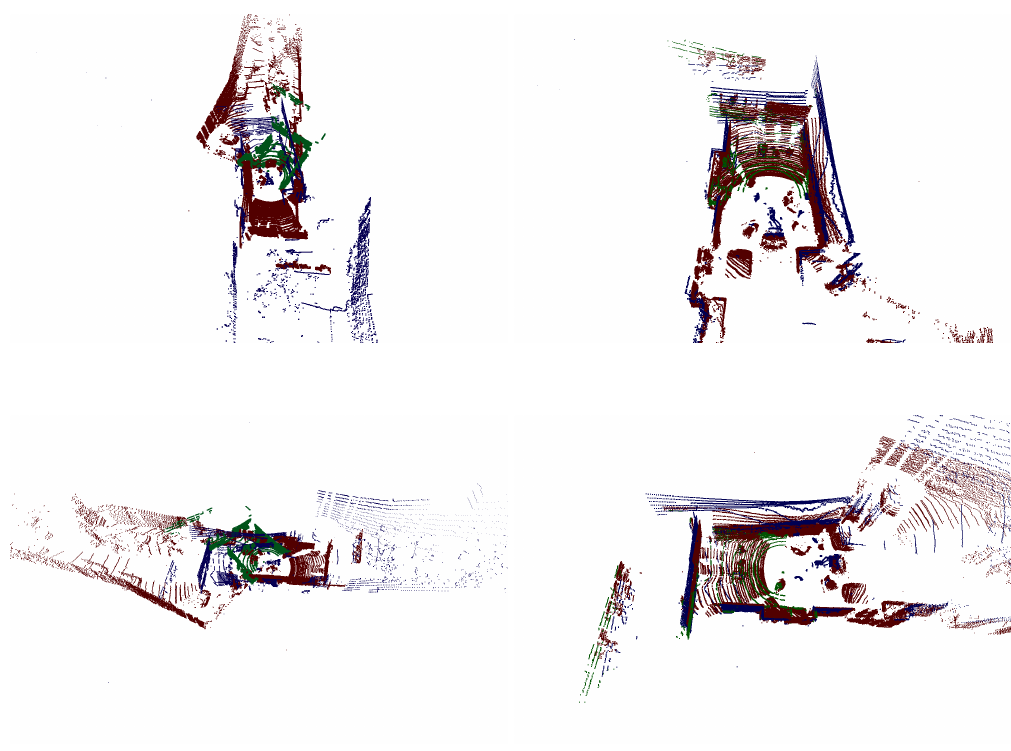
Figure 7. Point cloud fusion of two Velodyne VLP-16 LiDARs. The point clouds are colored in red and green, for the first and second sensors, respectively. First Column : without calibration; Second Column : with